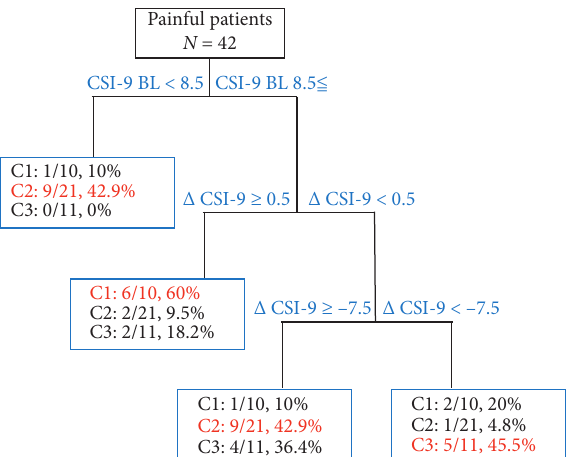
Figure 7: Decision tree analysis for cluster classification. The first predictive factor was CSI-9 BL < 8.5 or CSI-9 BL 8.5 ≦ . The second predictive factor was ∆ CSI-9 ≥ 0.5 or ∆ CSI-9 < 0.5. The third predictive factor was ∆ CSI-9 ≥ − 7.5 or ∆ CSI-9 < − 7.5. Each square box shows the percentage of cluster affiliation when each predictor is met. Abbreviations: CSI-9, Central Sensitisation Inventory-9; BL, baseline; ∆ , follow-up score minus the initial score; C,